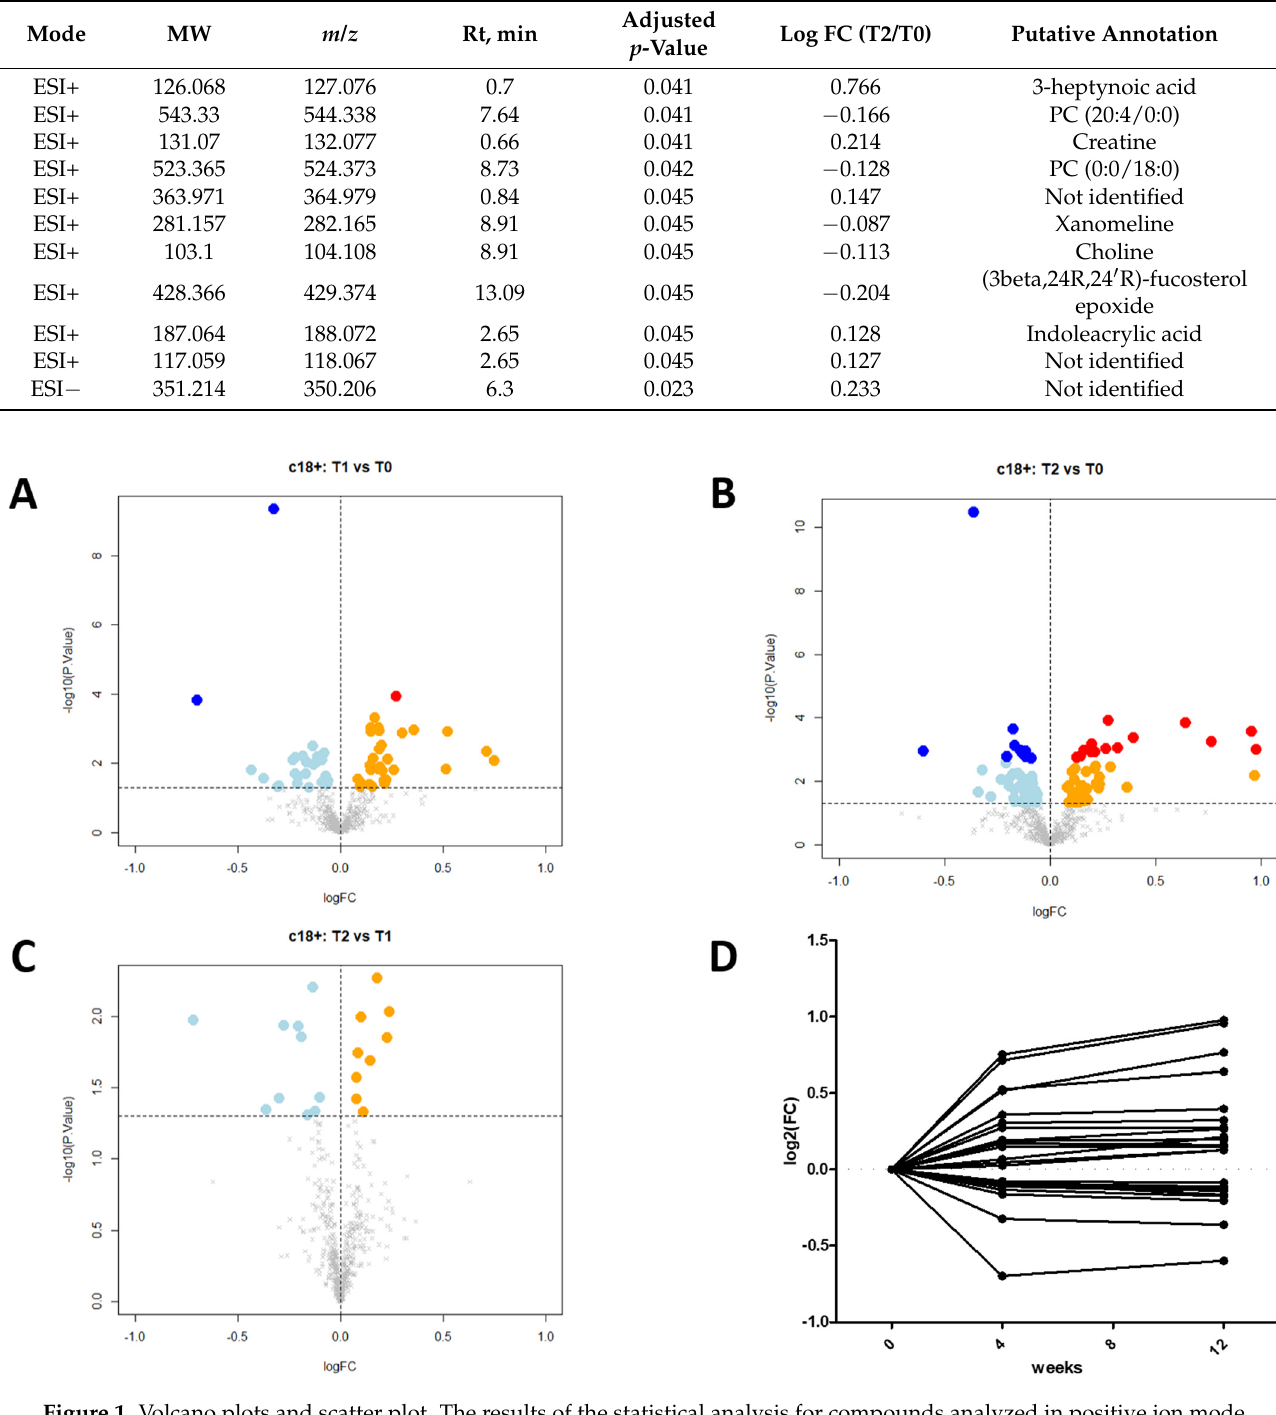
Figure 1. Volcano plots and scatter plot. The results of the statistical analysis for compounds analyzed in positive ion mode are summarized as a volcano plot of log2 fold-change (x-axis) versus − log10 p -values (y-axis), for three experimental designs: T1 vs. T0 ( panel A ), T2 vs. T0 ( panel B ), and T2 vs. T1 ( panel C ). Colored dots are the differentially abundant compounds: light blue and dark blue dots refer to compounds downregulated at p -value < 0.05 and adjusted p -value < 0.05, respectively; orange and red dots are compounds upregulated at p -value < 0.05 and adjusted p -value < 0.05, respectively. Scatter plot ( panel D ) shows the trend over time of the 19 differentially expressed compounds (adjusted p -value < 0.05).